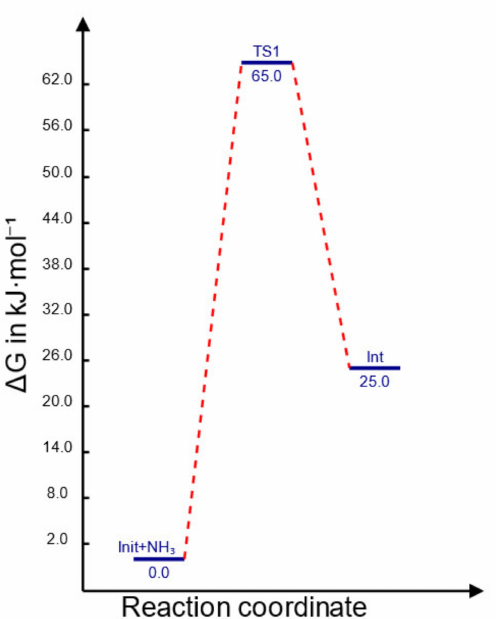
Figure 2. Energy profile of ammonia nucleophilic addition to nitrilium derivatives of closo -dodecaborate. The addition process led to the endergonic formation of [B 12 H 11 NCCH 3 NH 3 ] − (Int) as intermediate species. The Gibbs free energy of the addition reaction was 37 kJ · mol − 1 (tetrahydrofuran solution) and 25 kJ · mol − 1 (water solution). The length of C=N bonds ´ ´ was in the interval 1.24–1.25 Å. The length of the C–NH 3 bond was equal to 1.52 Å. [B 12 H 11 NCCH 3 NH 3 ] − (Int) has one intramolecular non-covalent contact between the hydrogen atom of the NH 3 -group and the H-atom of the cluster cage. In the case of tetrahydrofuran as a solvent, the distance of the intermolecular dihydrogen contact was ´ ´ shorter (1.74 Å) than with the water solution (1.77